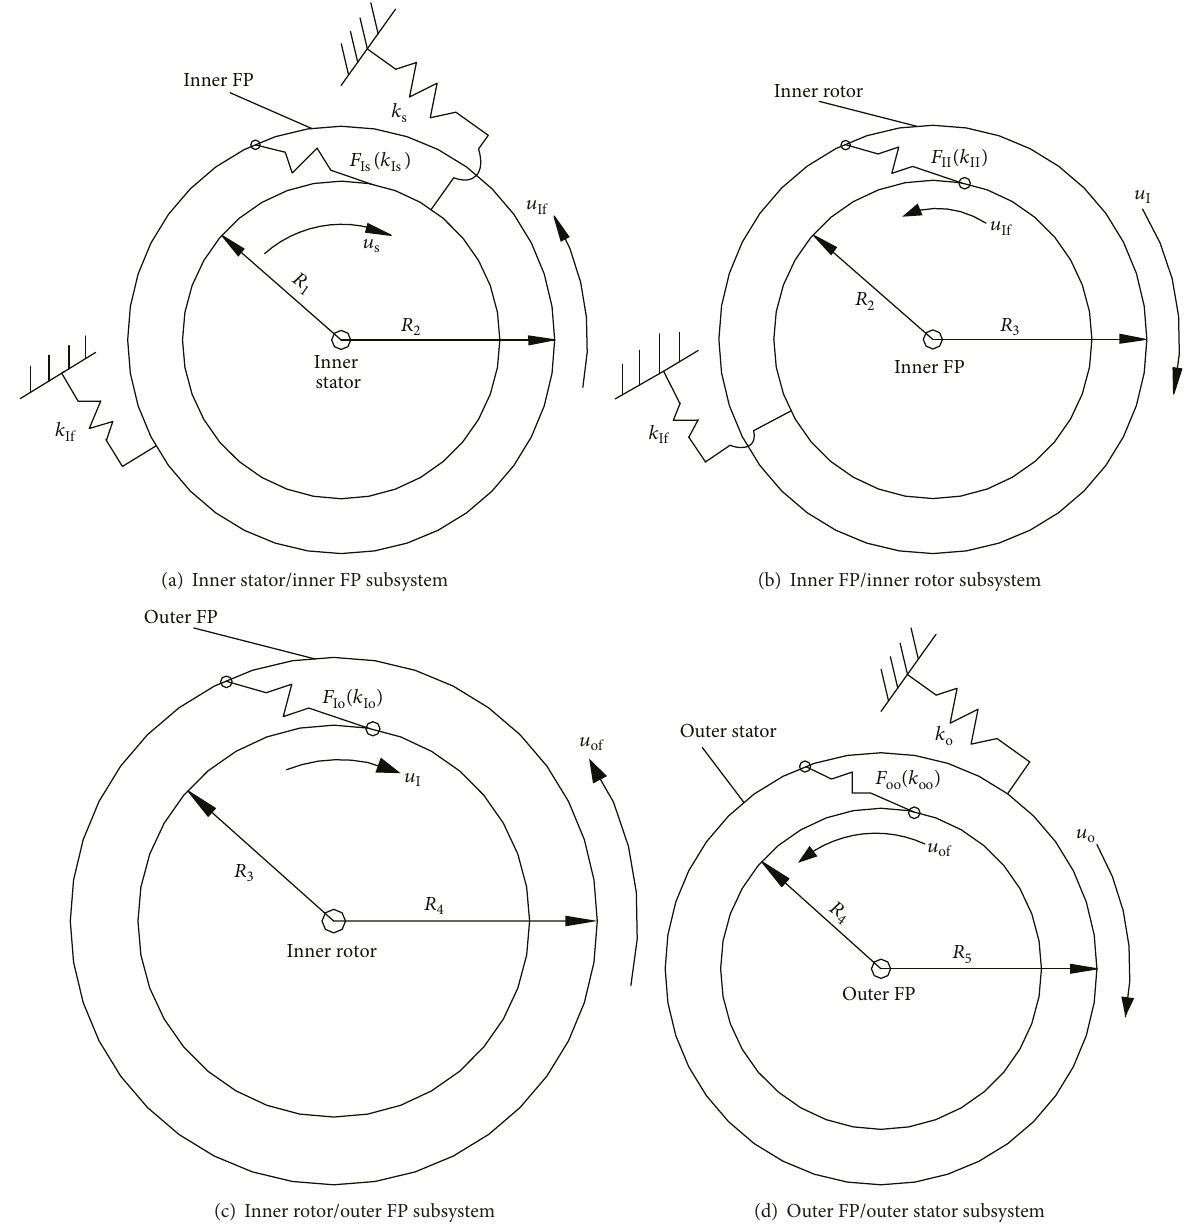
Figure 2: Nonlinear dynamic model of electromechanical integrated magnetic